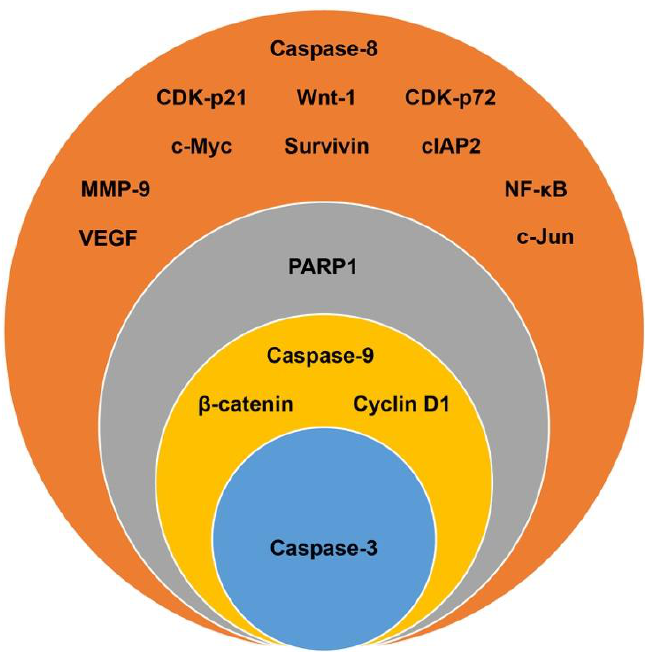
Figure 5. Replicability of 16 candidate biomarkers (CBs) identified in the 12 independent research papers selected for this study. The number of papers that each CB is reported in is arranged in descending order starting with the larger outer circle (orange), which shows CBs reported in two studies, followed by the grey circle, which shows CBs reported in three research papers; yellow circle showing CBs reported in four research papers, and finally the blue circle that shows the CBs reported in five research papers. The CBs reported in a single research paper were excluded.